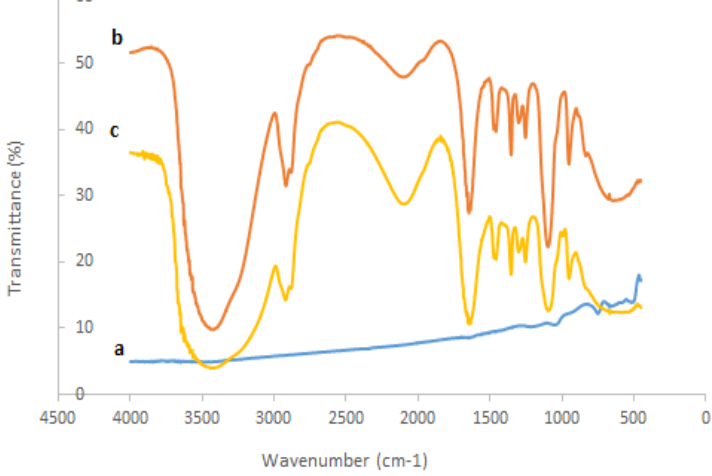
Figure 2. Fourier transform infrared spectroscopy spectra of ( a ) ZrO 2 ; ( b ) pure tyrosinase; ( c ) PEG- ZrO 2